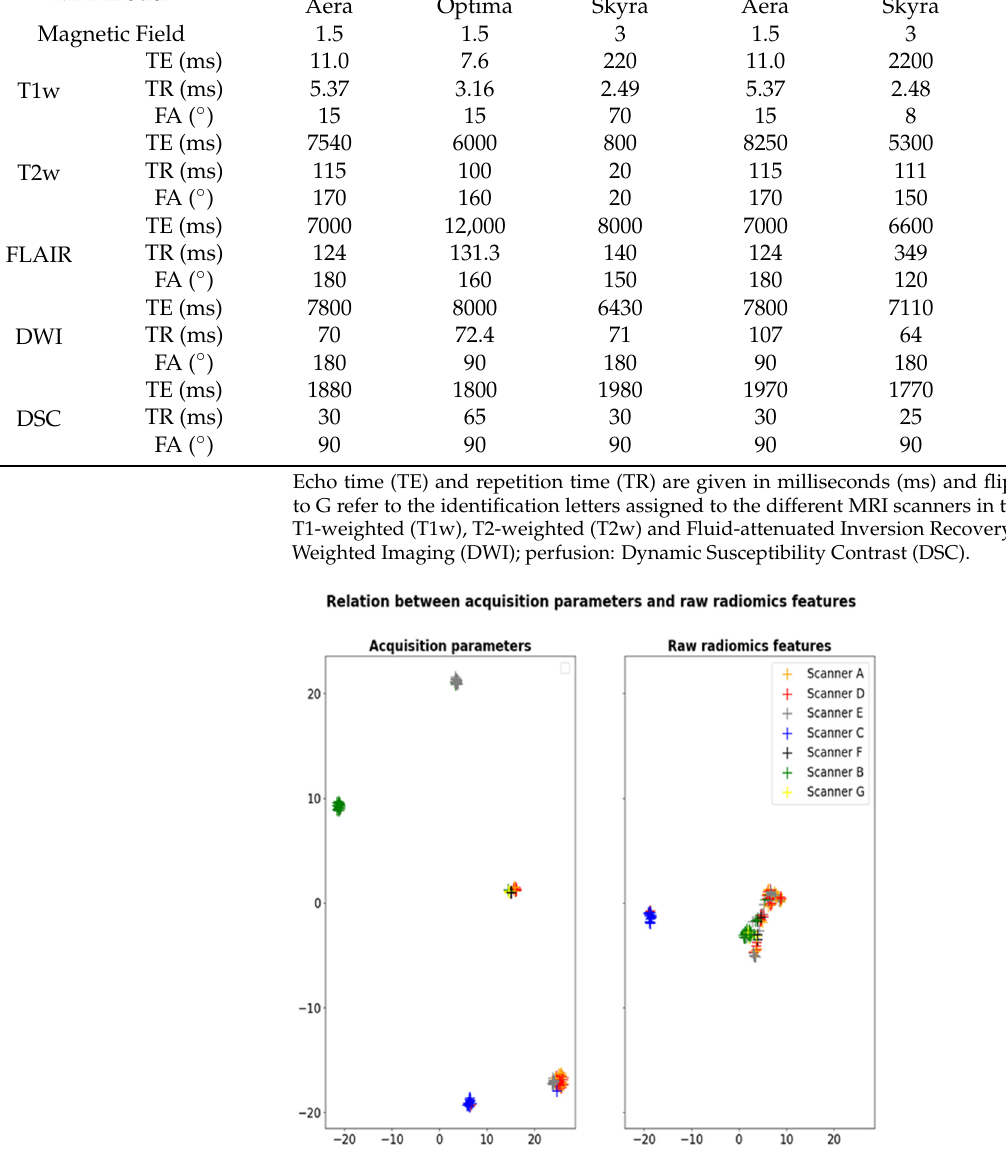
Table 2. Characteristics of each MRI protocol.